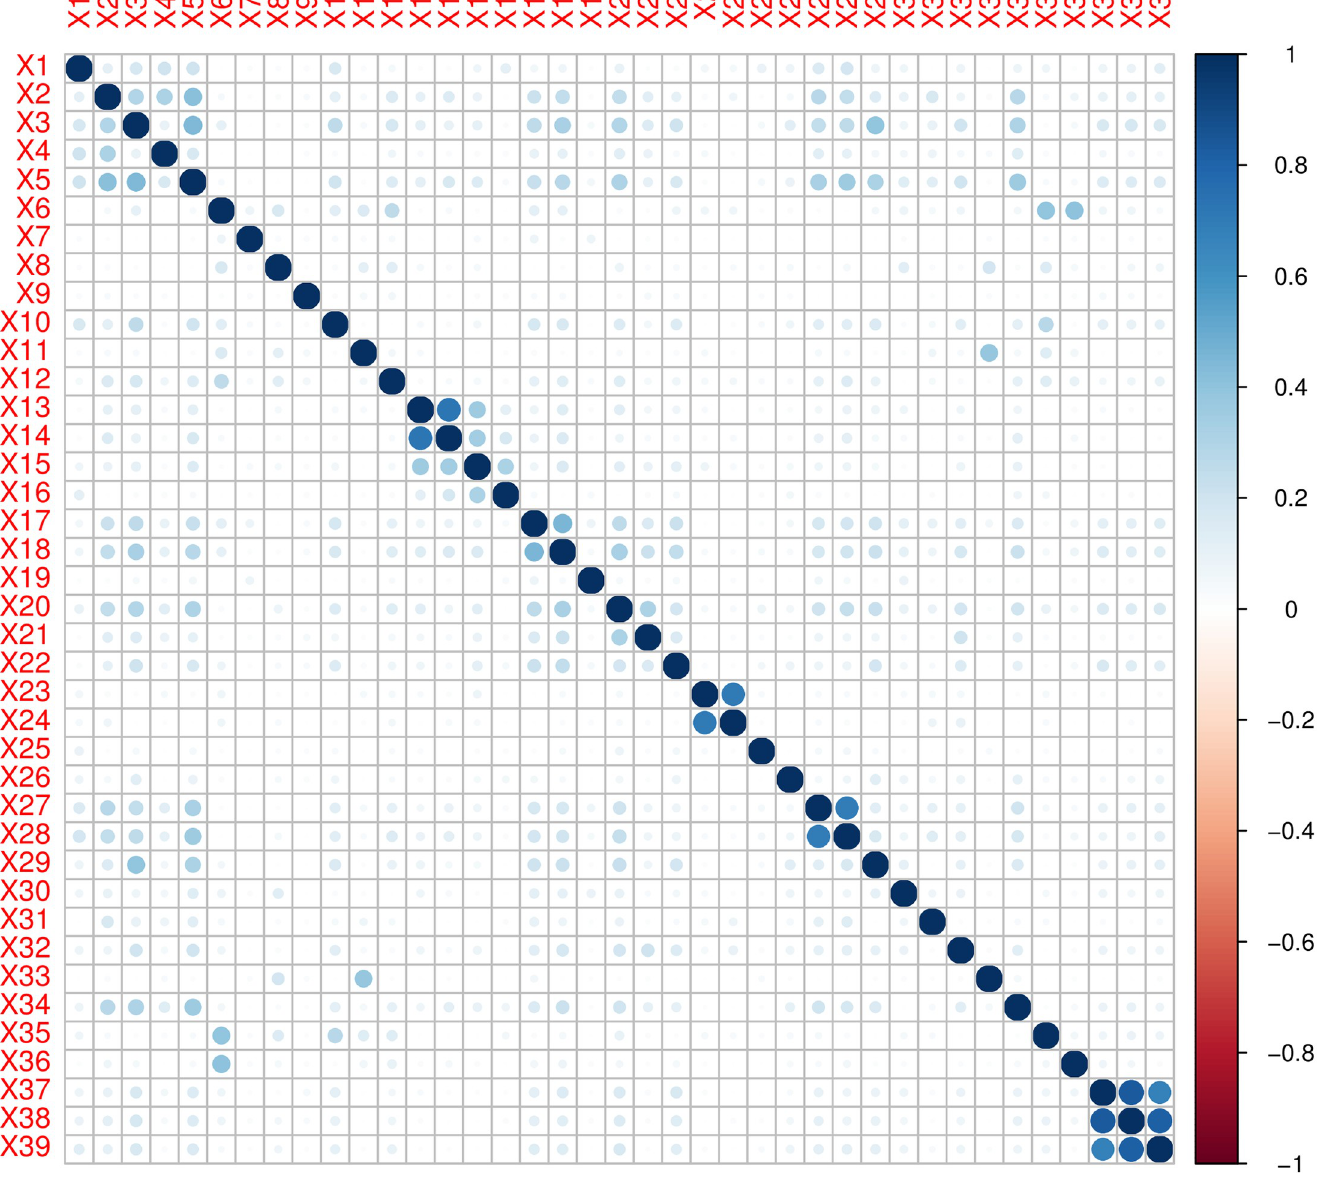
PLOS ONE | https://doi.org/10.1371/journal.pone.0219427 July 26,